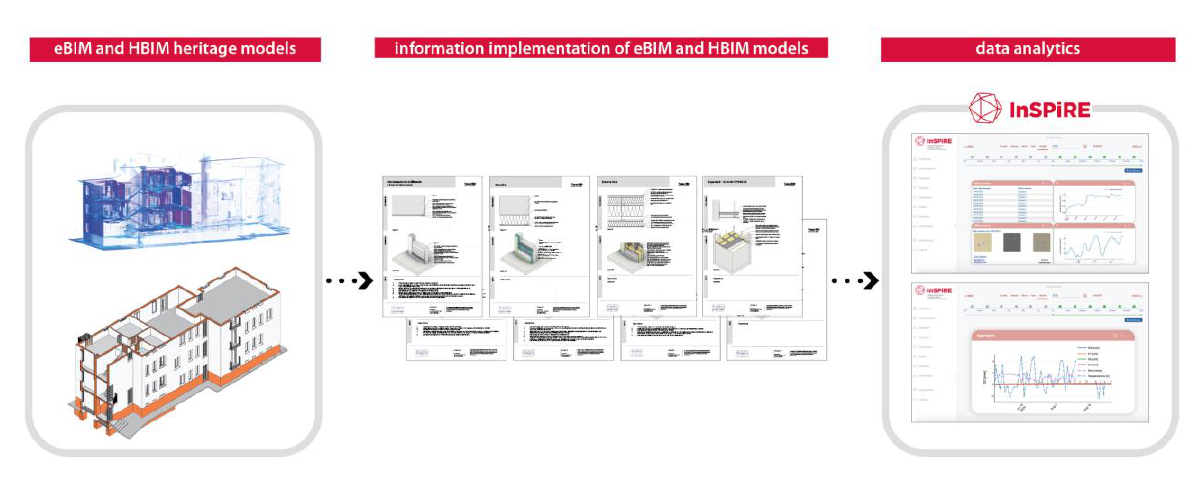
Figure 4. From 3D data modeling to data